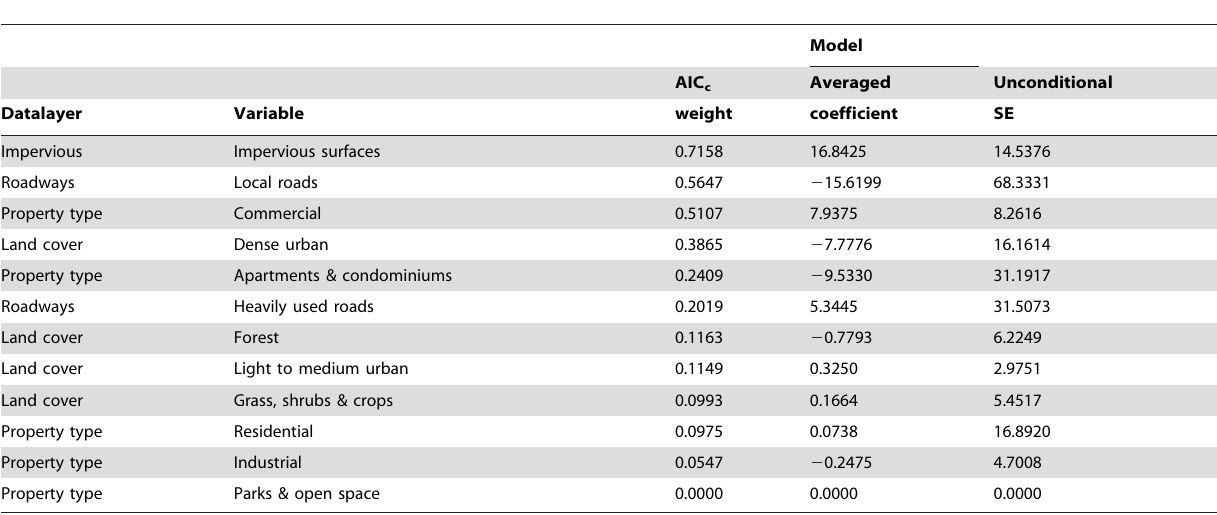
Table 2. AIC weights, model averaged parameter estimates and unconditional confidence intervals for each variable, ranked by AIC c